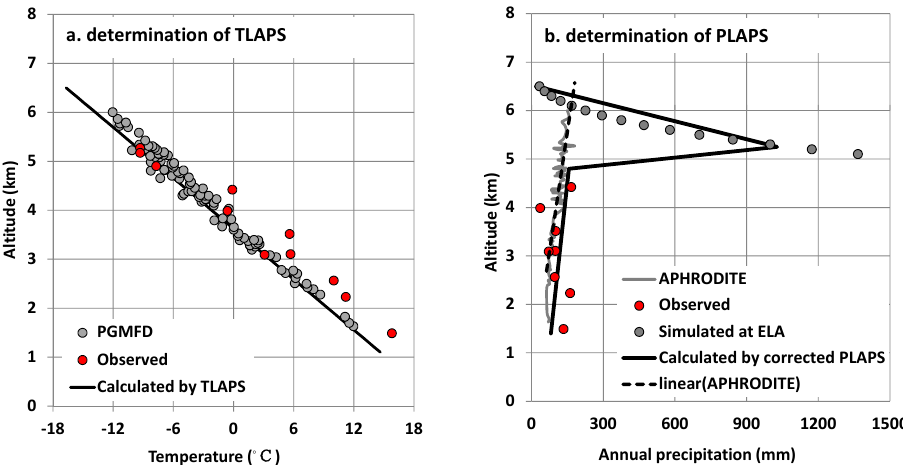
Figure 2. Comparison between the altitudinal distributions of the average annual temperatures based on observed values, Princeton’s Global Meteorological Forcing Dataset (PGMFD) values and temperature lapse rate (TLAPS) ( a ); and the annual precipitation based on the observed values, Asian Precipitation Highly Resolved Observational Data Integration Towards Evaluation (APHRODITE) values, Equation (3) results and corrected precipitation lapse rate (PLAPS) ( b ).